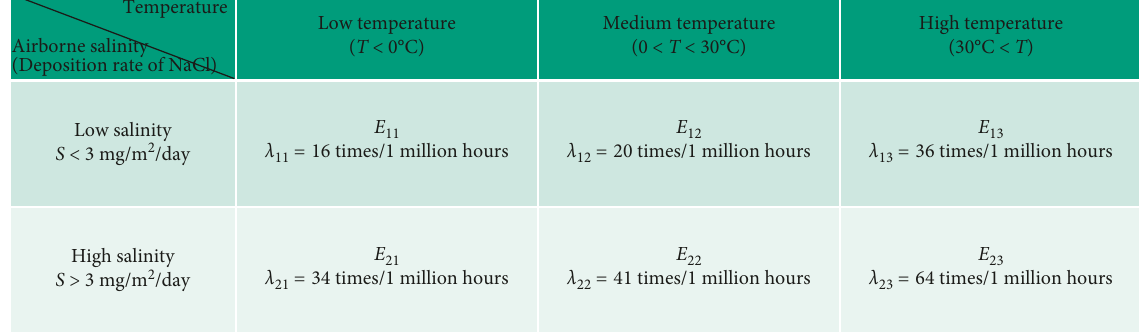
Figure 3: Environmental conditions and failure rates.